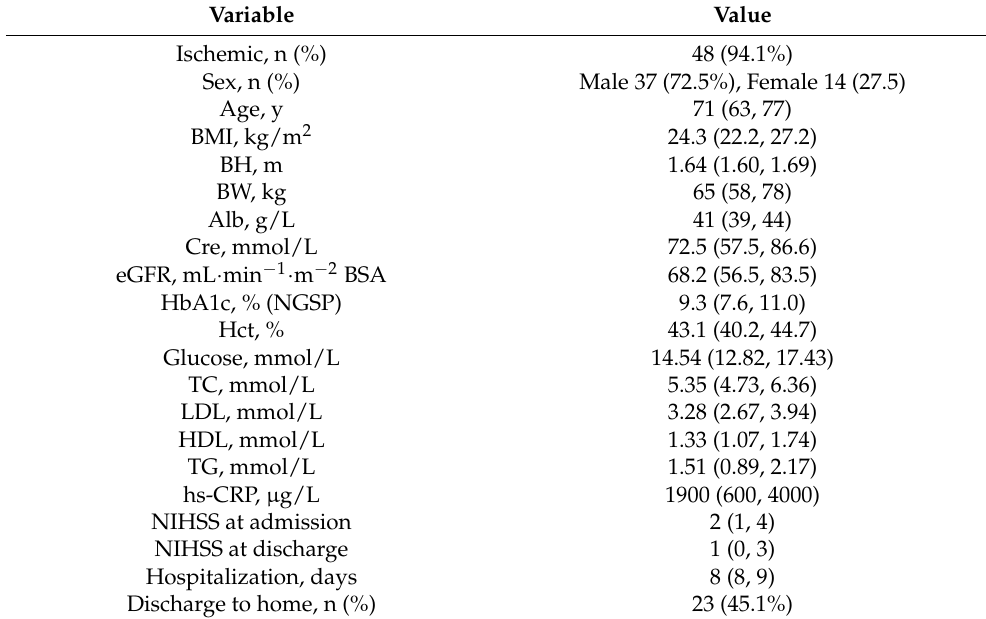
Table 1. Patient characteristics (N = 51).